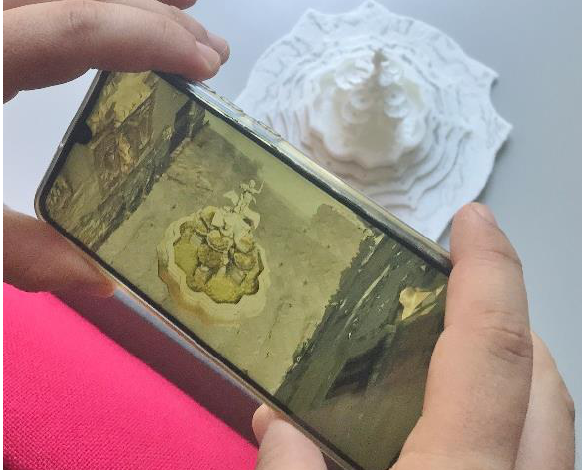
Figure 13. The testing of the indoor AR experimentation: the 3D virtual model of the Garraffo fountain inside its original location appears in correspondence of the 3D printed